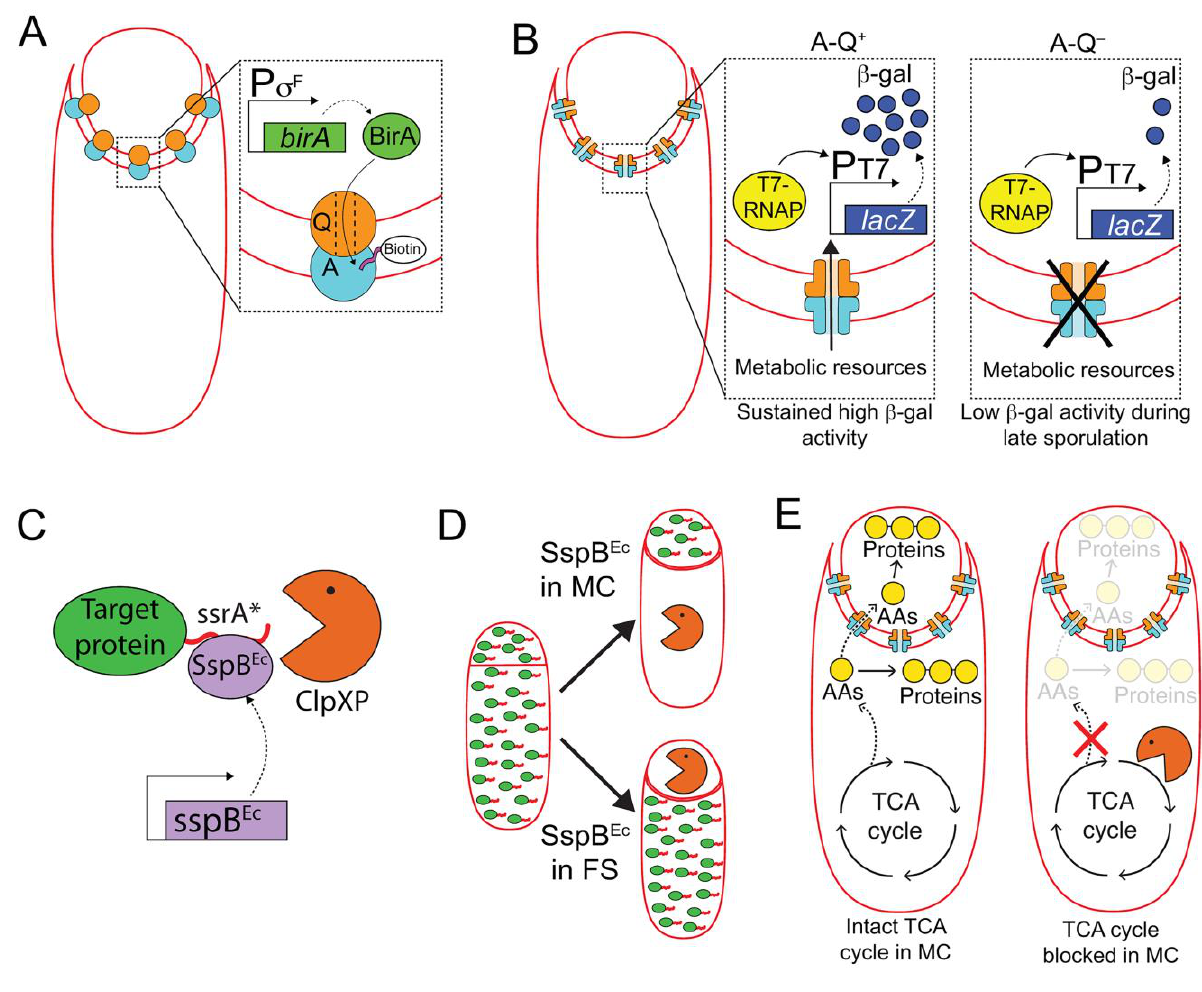
FIGURE 6: Harnessing cell-specific gene expression to study the function of A-Q complexes. (A) The forespore protein SpoIIQ (Q, orange circle) and the mother-cell proteins encoded in the spoIIIA operon (A, light blue circle), form trans-envelope complexes that bridge the fore- spore and mother-cell membranes during engulfment. Zoomed in panel: Biotin ligase (BirA, green) produced in the forespore is able to bio- tinylate a biotin acceptor peptide (pink) fused to the extracellular domain of the A protein, SpoIIIAH [111], indicating that A-Q complexes are channels (see panel B), and that the channel pore is open on the forespore side and large enough for BirA to reach the extracellular domain of SpoIIIAH. (B) The activity of a heterologous RNA polymerase (T7 RNAP, yellow) produced in the forespore un der σ F control is monitored by the accumulation of β -galactosidase ( β -gal, dark blue circles) produced through the expression of a lacZ gene under the control of a T7 RNAP-dependent promoter. In the presence of A-Q channels (A-Q + , left zoomed in panel), sustained β -galactosidase activity is detected throughout sporulation. In the absence of A-Q channels (A-Q – , right zoomed in panel), β -galactosidase activity drops at later sporulation stages. Camp and Losick [112] proposed that A-Q channels constitute feeding tubes through which the mother cell transfers metabolic re- sources to the forespore to maintain biosynthetic activities at late sporulation stages. (C) The ssrA*/SspB Ec inducible protein degradation system [114]. SspB Ec (purple) binds to ssrA* (red) fused to the C-terminus of target proteins (green), and delivers the target proteins to the endogenous B. subtilis protease ClpXP (orange pacman) for degradation. (D) Cell-specific degradation of target proteins during sporulation is achieved by expressing sspB Ec from mother cell- or forespore-specific promoters [113]. Target proteins represented by green ovals tagged with ssrA (red line); degradation represented by orange pacman. (E) Left cell: Mother-cell TCA cycle provides metabolic precursors, such as amino acids (AAs, yellow circles), to support protein synthesis in both the mother cell and the forespore [115]. Mother-cell metabolic pre- cursors could be transported to the forespore via A-Q channels, in keeping with the feeding tube model. Right cell: Degradation of TCA cycle enzymes in the mother cell blocks protein synthesis in both the mother cell and the forespore OPEN ACCESS | www.microbialcell.com 8 Microbial Cell | JANUARY 2021 | Vol. 8 No. 1